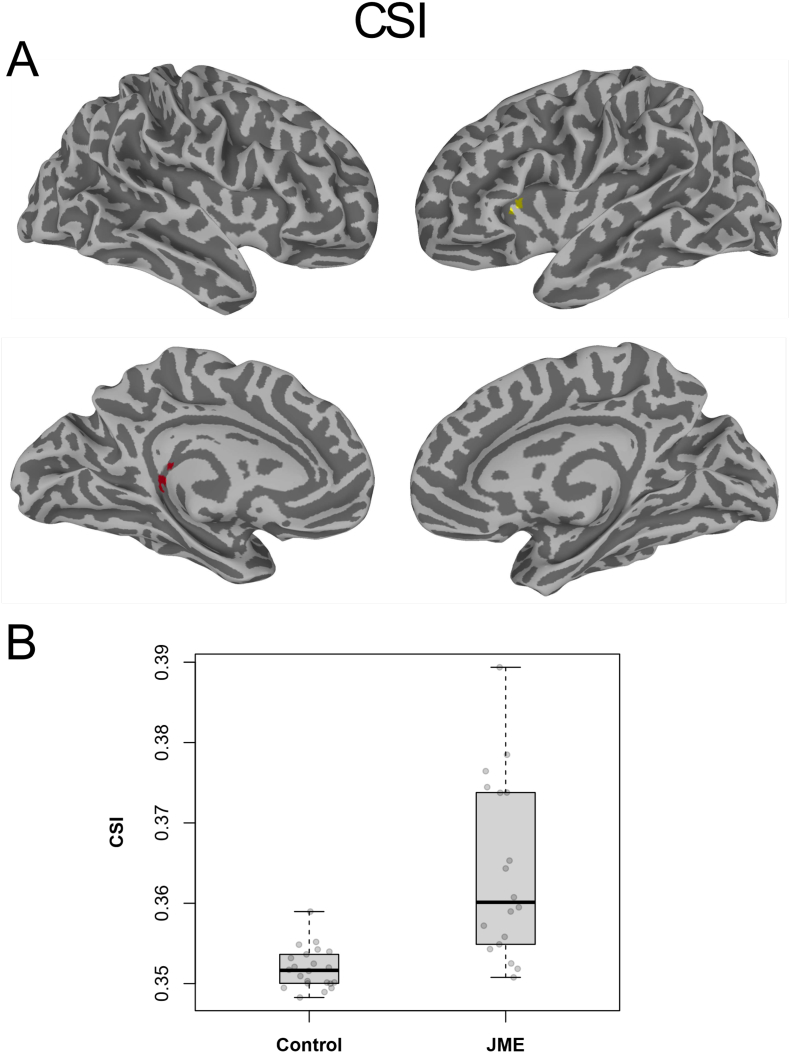
(A) Brain regions with statistical significant difference (Global FPR < 5%) in CSI between healthy controls and JME patients; (A) Boxplots of the average CSI values for the individual subjects in the brain regions of interests depicted in (A) with significant group difference. Cluster color encoding is arbitrary due to ETAC enhancement.